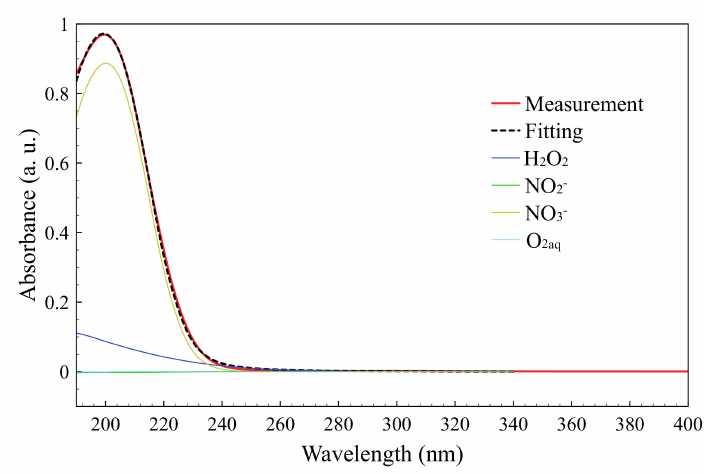
Figure 3. Fitting and deconvolution of deep ultraviolet (DUV) absorption spectrum of DI water treated with ambient-air glow discharge (AAGD).